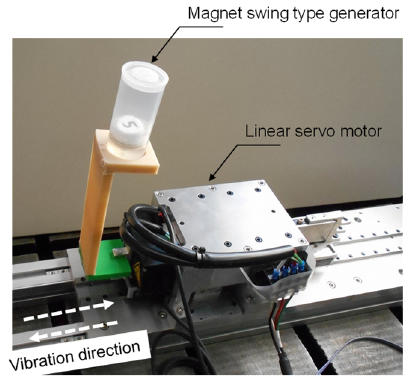
Figure 11. Vibration experiment using a linear motor.